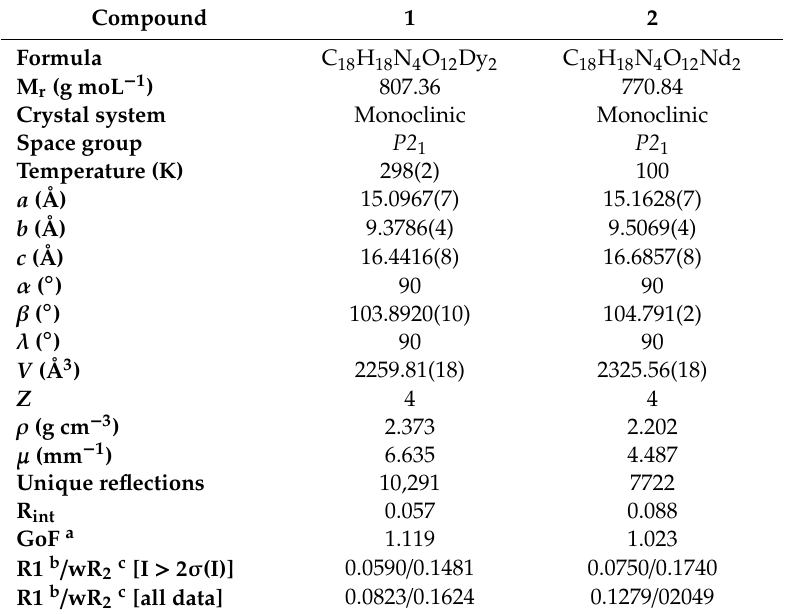
Table 1. Crystallographic data and structure refinement details of compounds 1 and 2